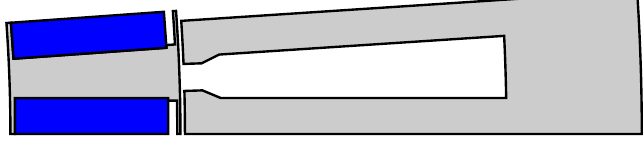
Figure 3. Spoke type motor with Ferrite PMs (Spoke).